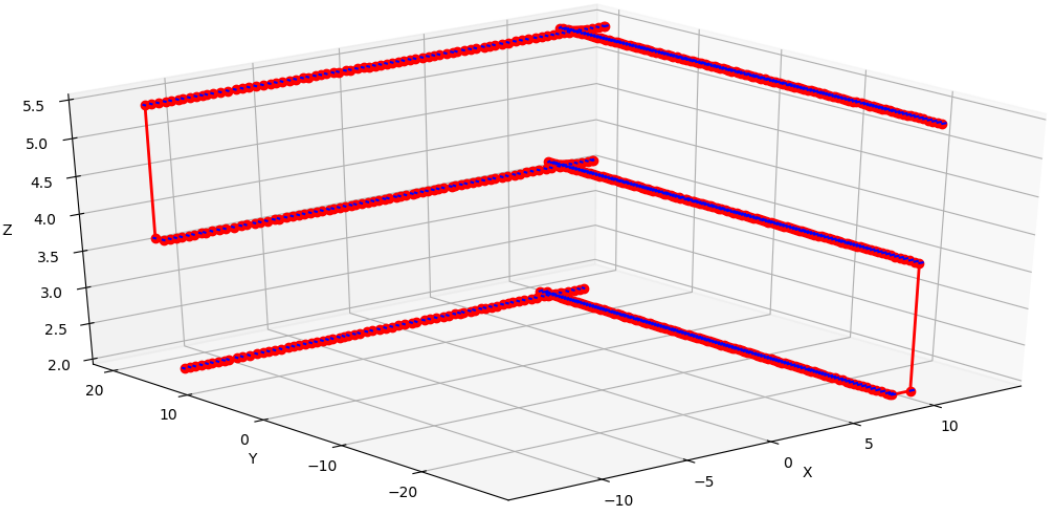
Figure 15. Initial Mission in Gazebo-ROS.